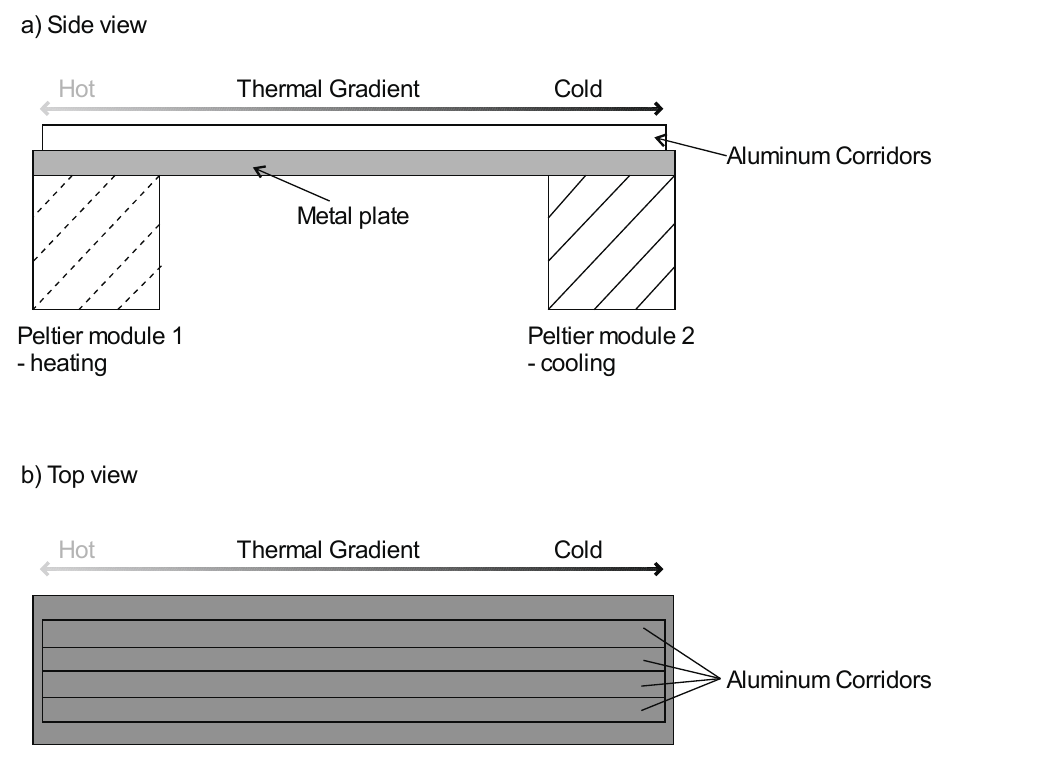
Figure 1. Equipment used to generate the thermal gradient for measuring Callosobruchus maculatus beetles’ thermal preferences. Individual beetles were placed in each corridor, and the corridors were covered with transparent plastic wrap. After 75 min, a thin thermocouple was used to measure the temperature of the aluminum substrate next to the sitting beetle.